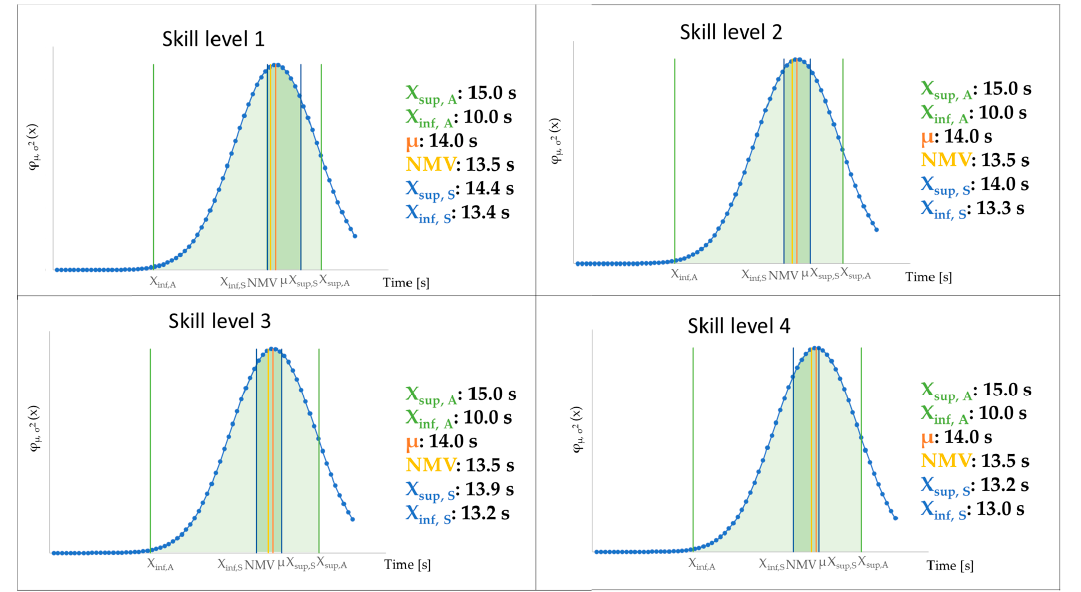
Figure 19. Gaussian distribution of gluing.